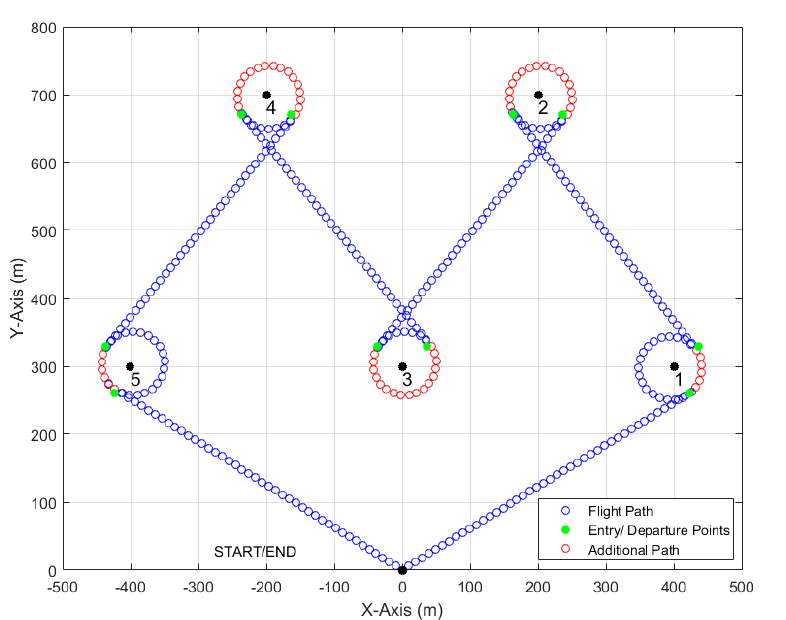
Figure 9. Tangential loitering